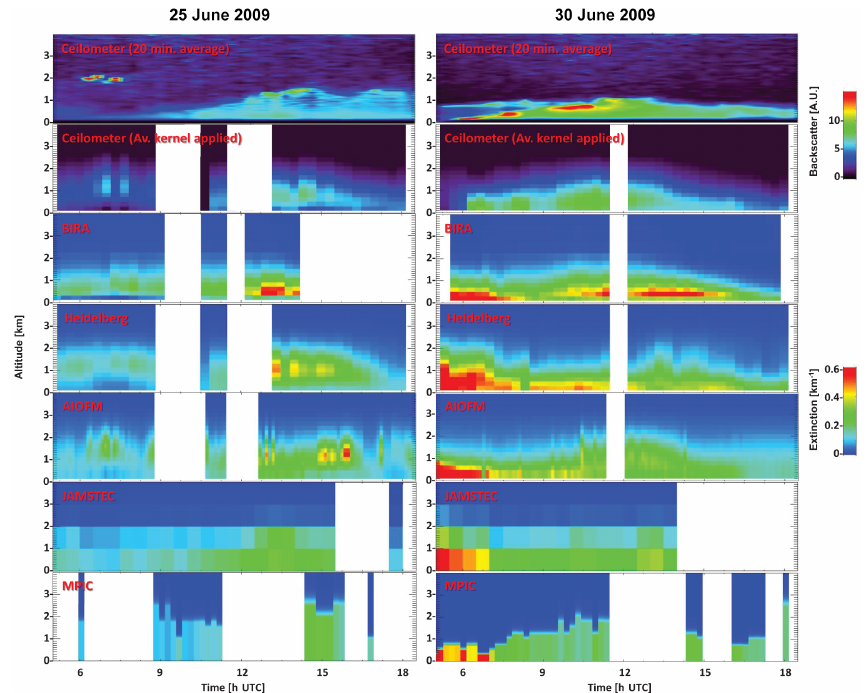
Figure 5. Same as Fig. 5 but for 25 June (left) and 30 June